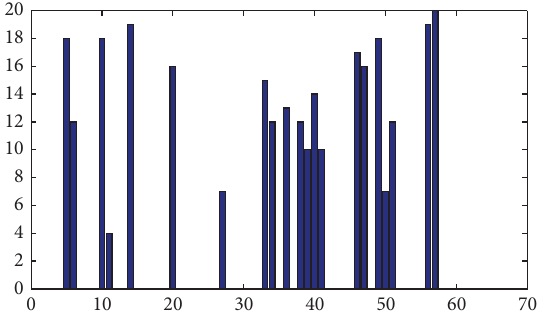
Figure 8: 60 characteristic attributes of a feature point.